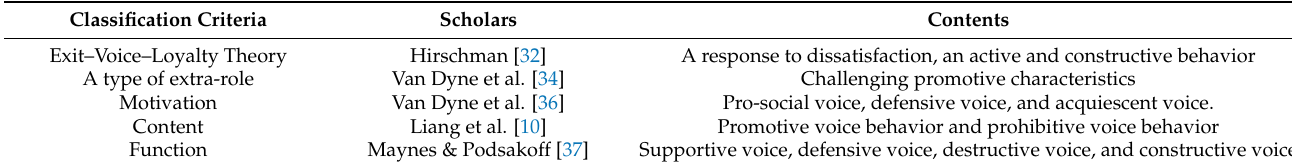
Table 1. Classifications of voice